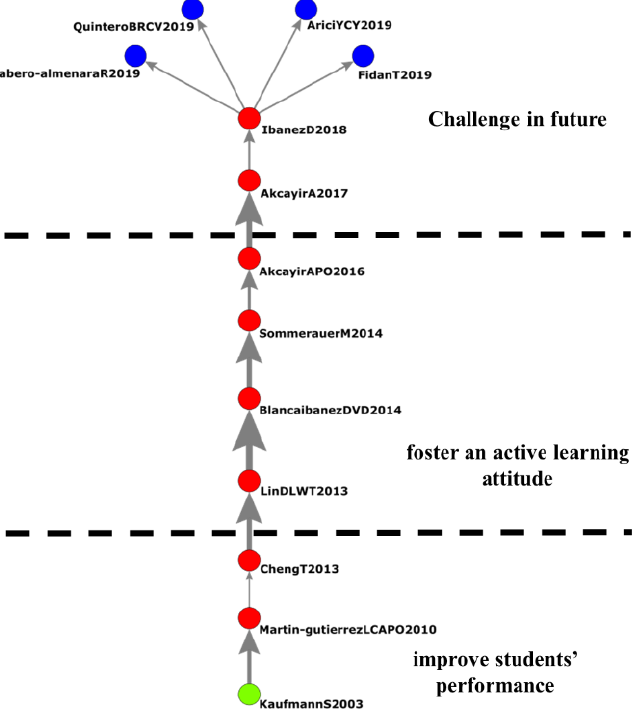
Figure 8. Application of AR technology in manufacturing.